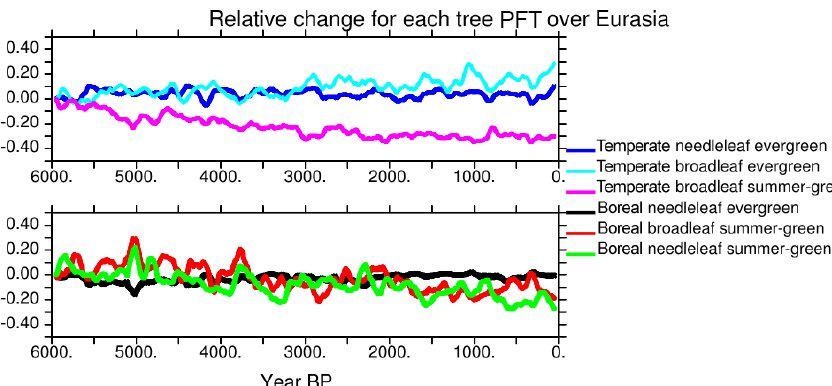
Figure 13. Evolution of the different tree PFTs in Eurasia, expressed as the percentage change compared to their 6000BP initial state. Each colored line stands for a different PFT. Values have been smoothed by a 100-year running mean.